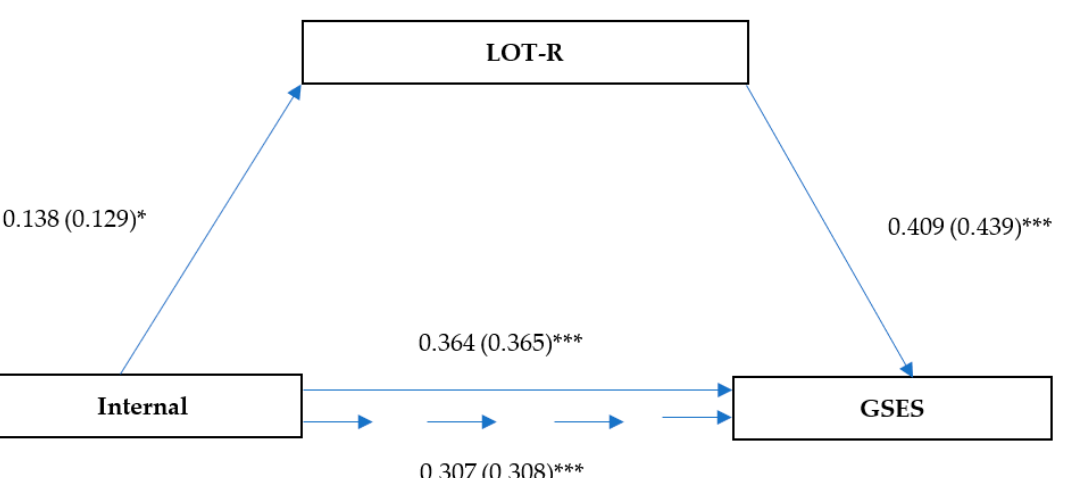
Figure 4. Model of relationships between health locus of control (impact of others), dispositional optimism, and self-efficacy. Unstandardized coefficient (standardized coefficient); *** p < 0.001.